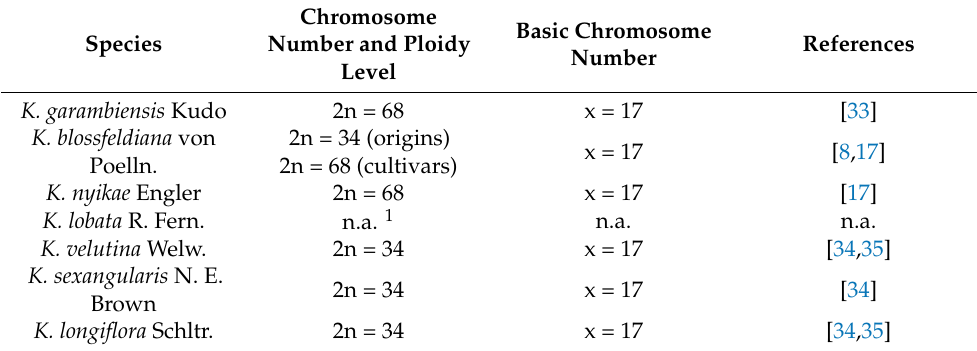
Table 5. Chromosome number and ploidy level of studied Kalanchoe